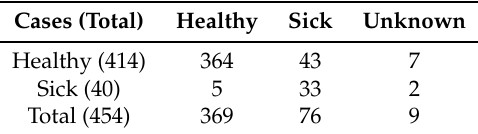
Table 3. Validation using our clinical